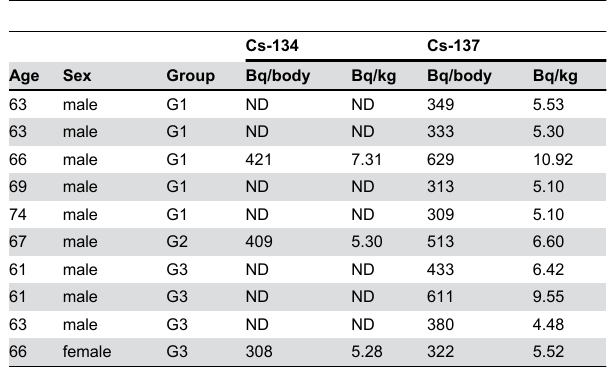
Table 4. Proportion of residents with internal radiation exposure of Cs-137 above the detection limit by sex and